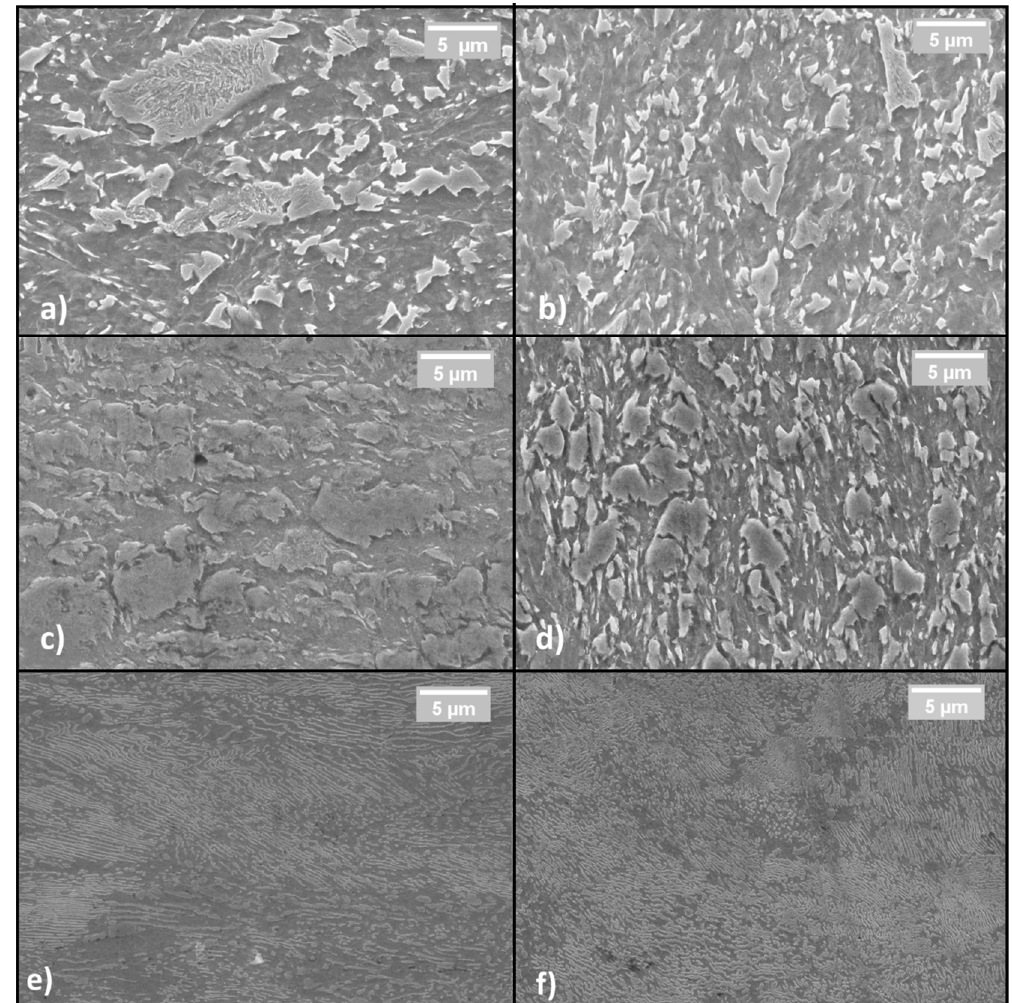
Figure 3. Sample microstructures in the longitudinal direction observed with SEM: ( a , c , d ). Sample microstructures in the transversal direction ( b , d , f ); from top to bottom: As-received DP steel ( a , b ); cold-rolled DP steel ( c , d ); C67 ( e , f ).